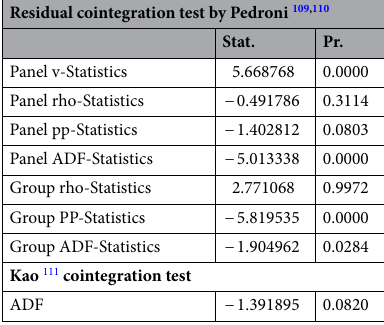
Table 5. Cointegration Test.